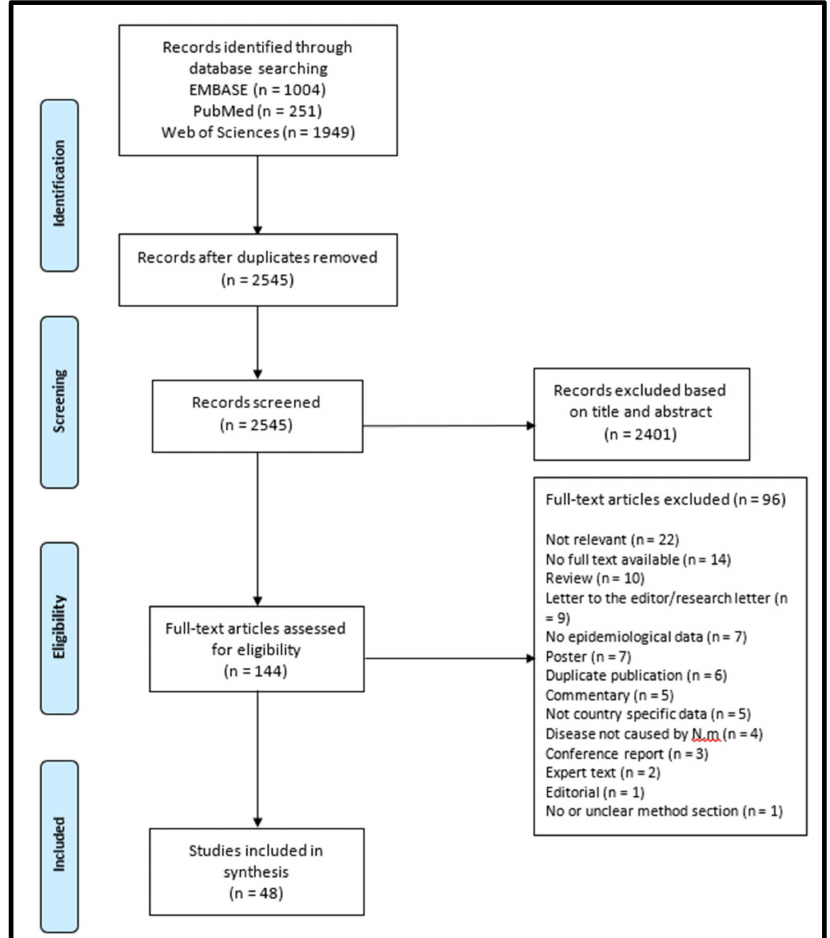
Figure 1. Flowchart of study and selection